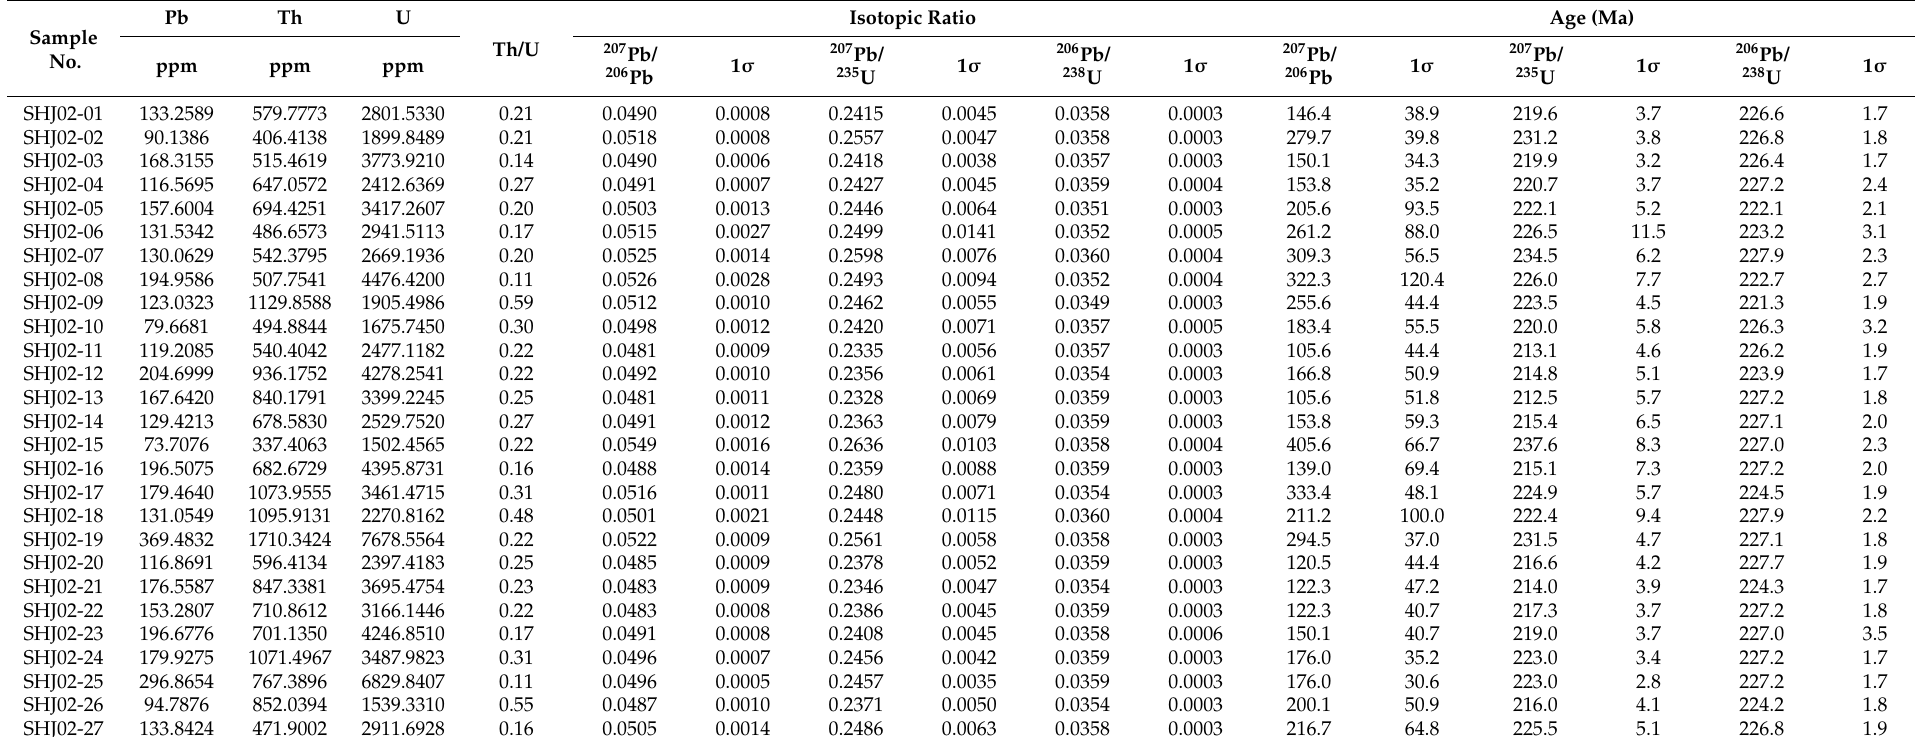
Table 1. Analytical data of zircon LA-ICP-MS U-Pb dating for the Xiangcaoping granite. Sample